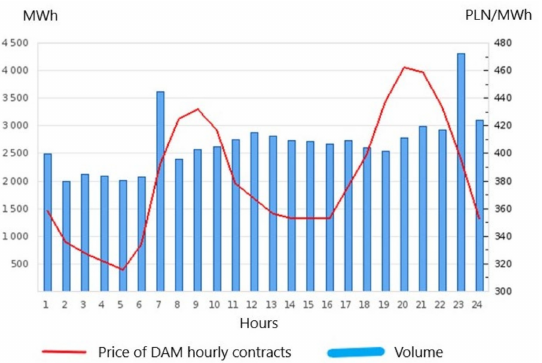
Figure 3. Prices and volumes of energy on the TGE as on the delivery day on 16 June 2021. FIXING I-DAM hourly contracts (Source: own work based on data from